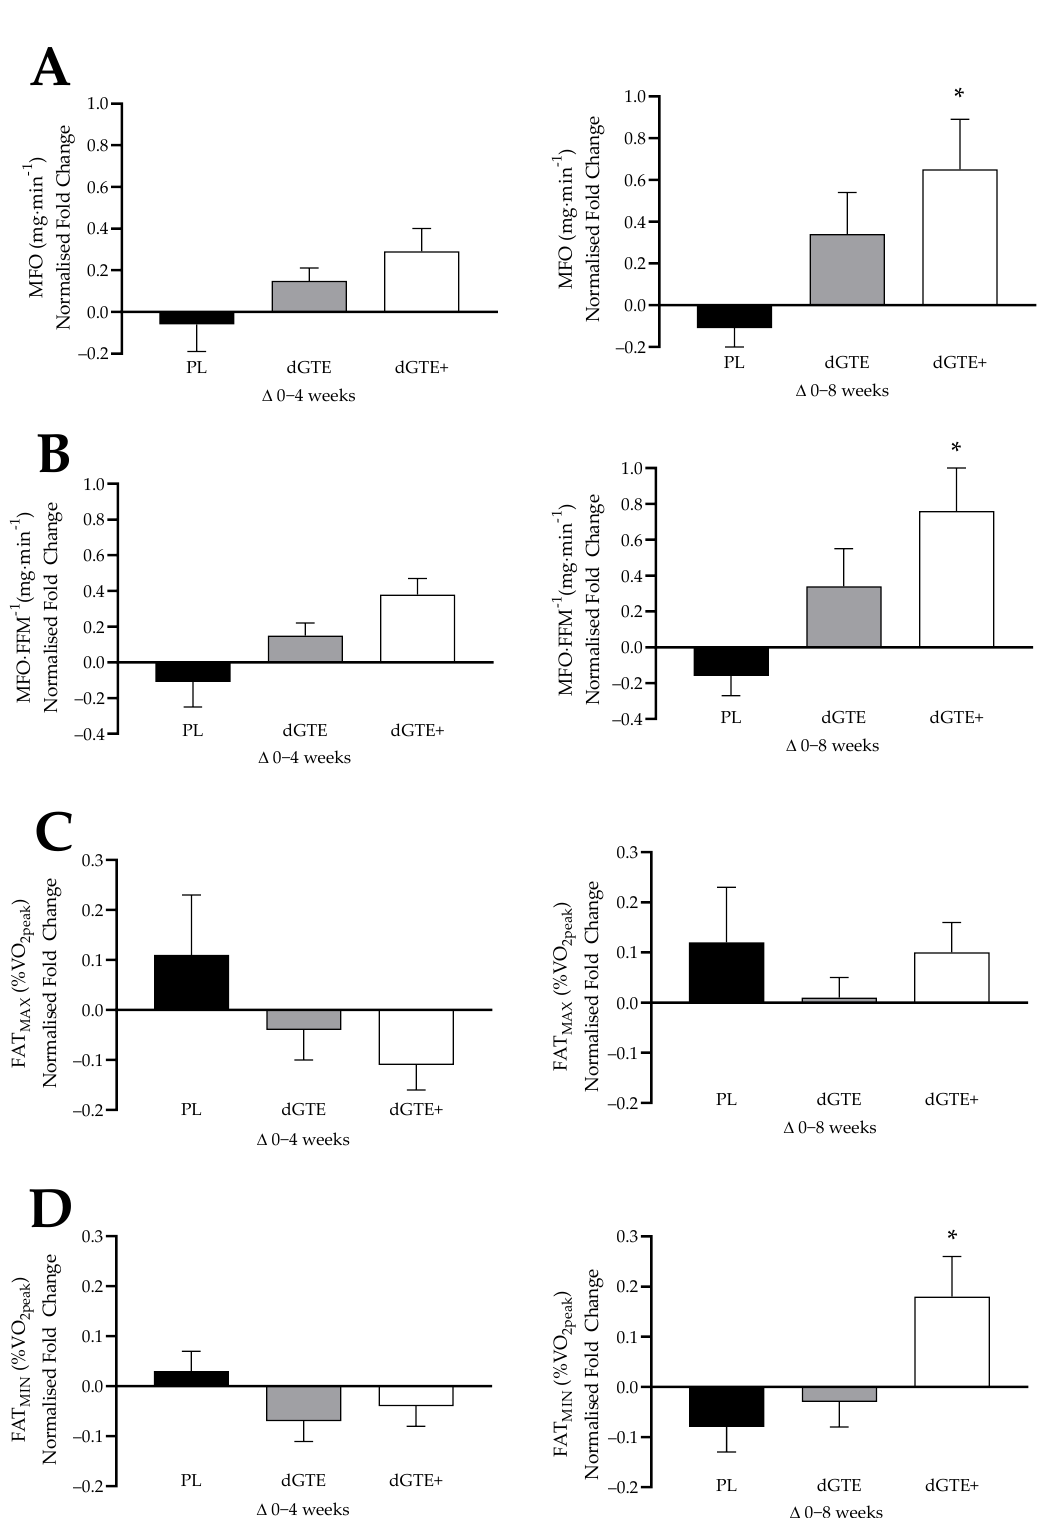
Figure 1. Mean normalised fold change for FAT MAX test parameters between groups by week 4 ( ∆ 0–4 weeks) and week 8 ( ∆ 0–8 weeks) of the intervention; showing ( A ) maximal fat oxidation rate (MFO), ( B ) relative maximal fat oxidation rate per kg FFM (MFO · FFM − 1 ), ( C ) exercise intensity at which MFO occurs (FAT MAX ), and ( D ) exercise intensity where fat oxidation deemed zero (FAT MIN ). PL = placebo; dGTE = decaffeinated green tea extract; dGTE+ = decaffeinated green tea extract with antioxidants. * significantly different from PL ( p ≤ 0.034).